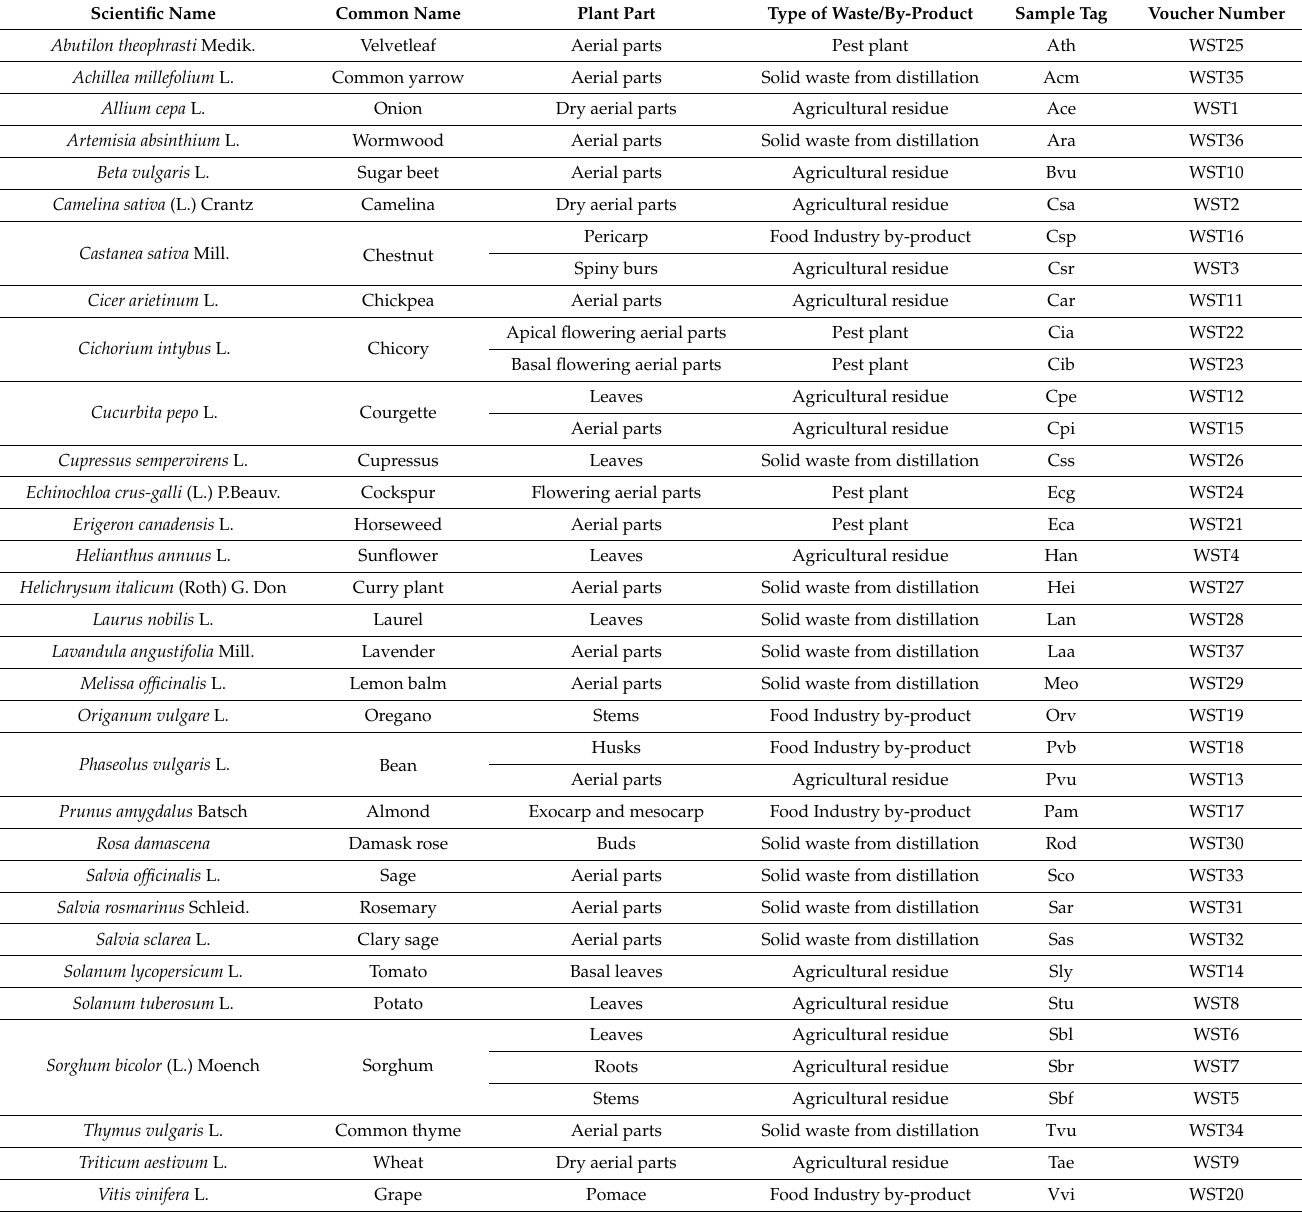
Table 1. Plant-neglected matrices investigated in this work, their source (plant scientific and common name and plant part), and used tag are reported together with the type of by-product. Plant scientific names have been updated following the World Checklist of Vascular Plants (WCVP 2020: World Checklist of Vascular Plants). Available online: https://wcvp.science.kew.org/ (accessed on 19 May